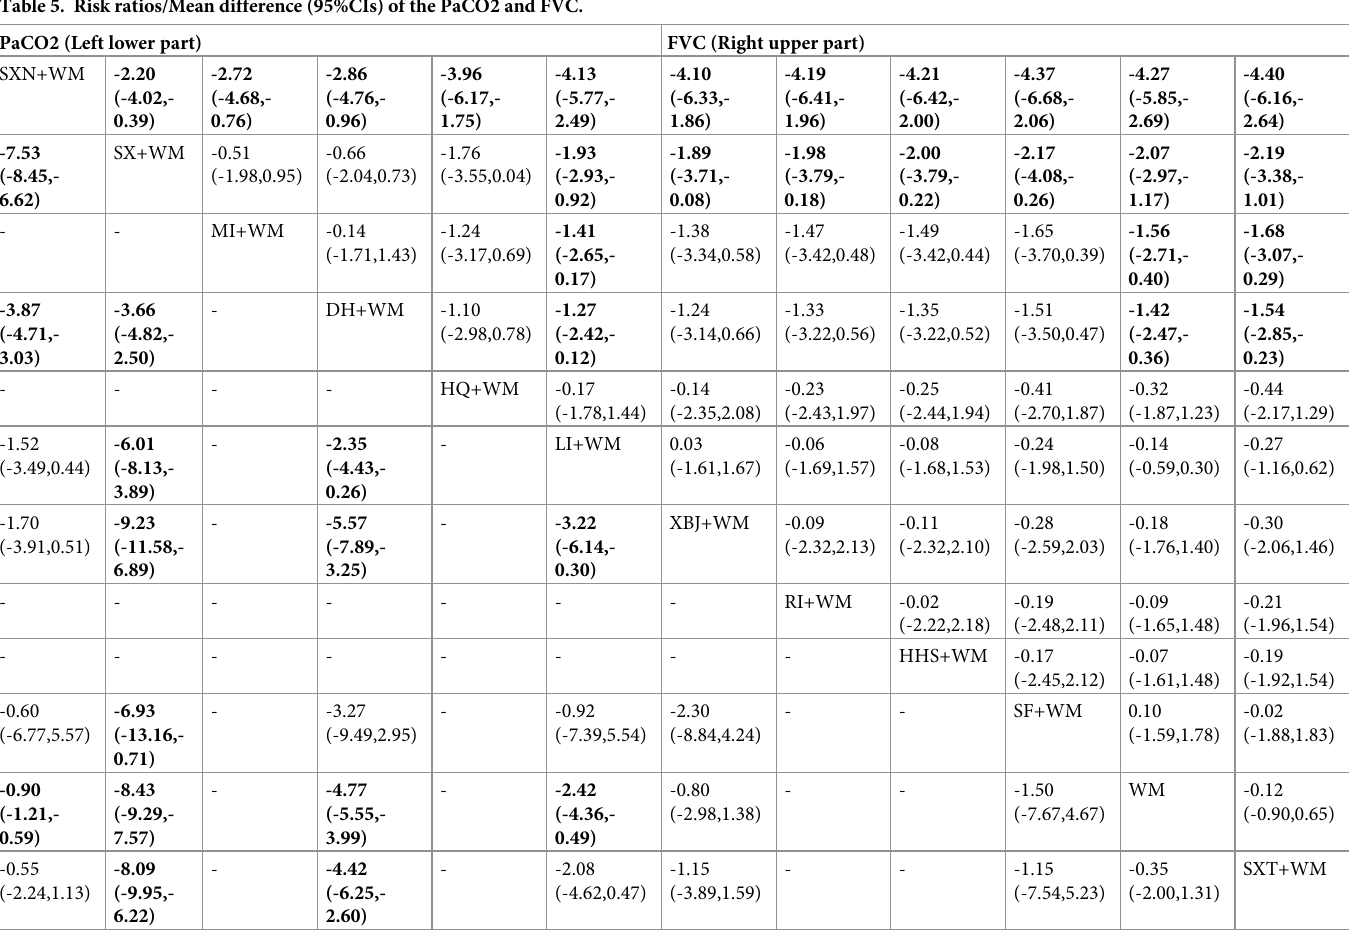
Table 5. Risk ratios/Mean difference (95%CIs) of the PaCO2 and FVC. PaCO2 (Left lower part)